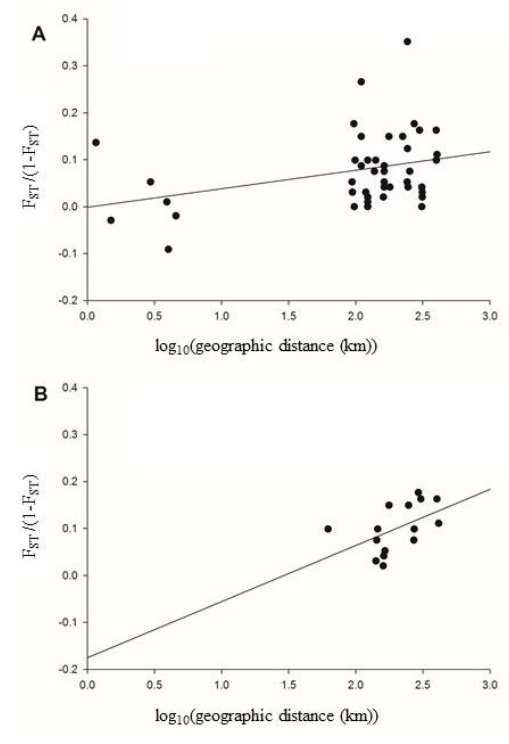
Figure 3. Scatter plot and regression line of genetic and geographic distance for all Sri Lankan Ae. aegypti populations. ARLEQUIN was used to test the correlation between the linear genetic distance (F ST / (1-F ST )) and the log 10 (geographic distance) using a Mantel test. A positive correlation was observed between the geographic distance and the genetic distance (r 2 = 0.11, p = 0.0001) when including all populations ( A ). This revealed that F ST increased with increasing geographic distance thus there is some, albeit weak, evidence for isolation by distance among collections. A positive correlation was observed between the geographic distance and the genetic distance (r 2 = 0.50, p = 0.0001) when excluding those populations that were close to one another ( B ).